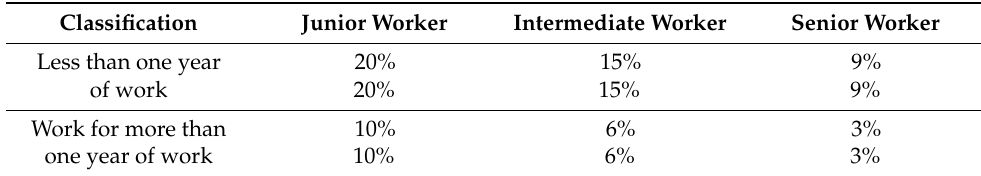
Table 7. Division of natural dismissal rate of bridge and tunnel operation and maintenance unit of operation and maintenance project of the Shuohuang Railway Company. Classification Junior Worker Intermediate Worker Senior Worker Less than one year of work Work for more than 10% one year of work